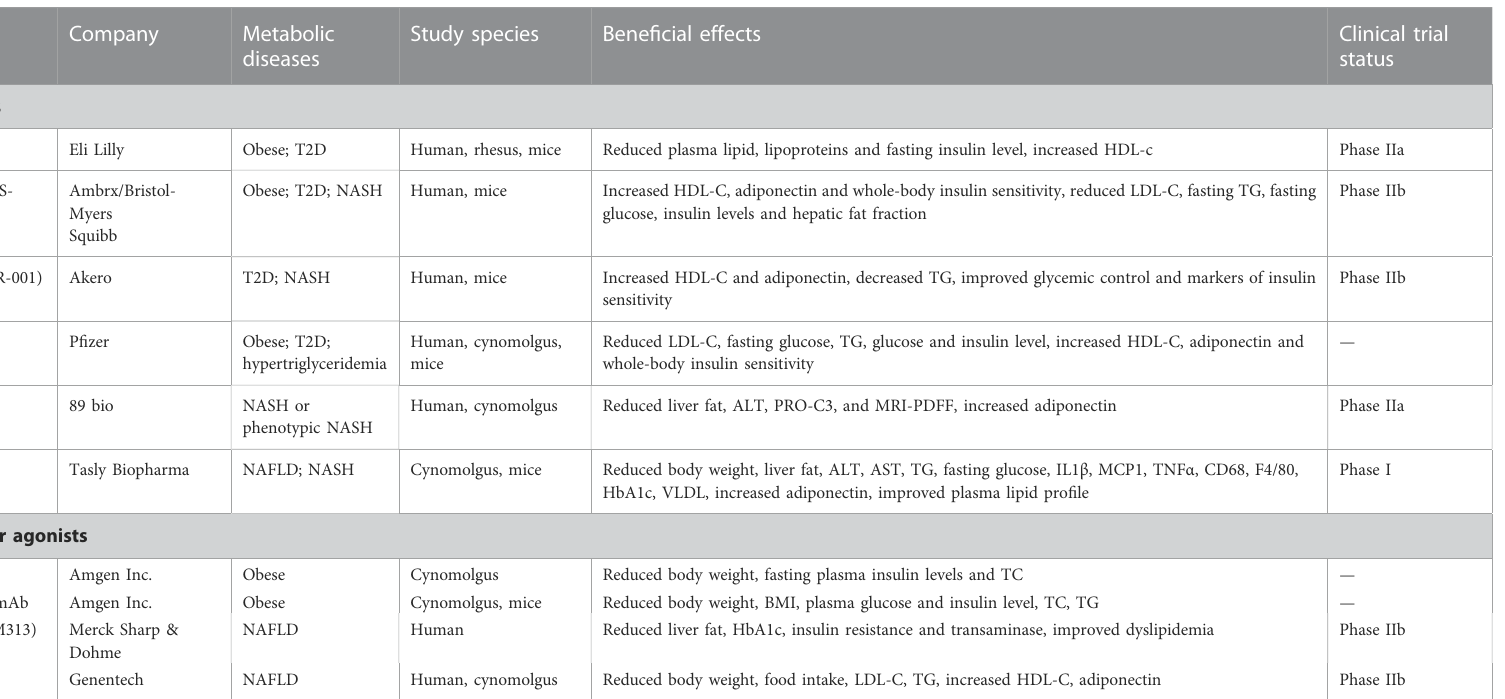
TABLE 1 Pharmaceutical development of FGF21-based drugs for metabolic